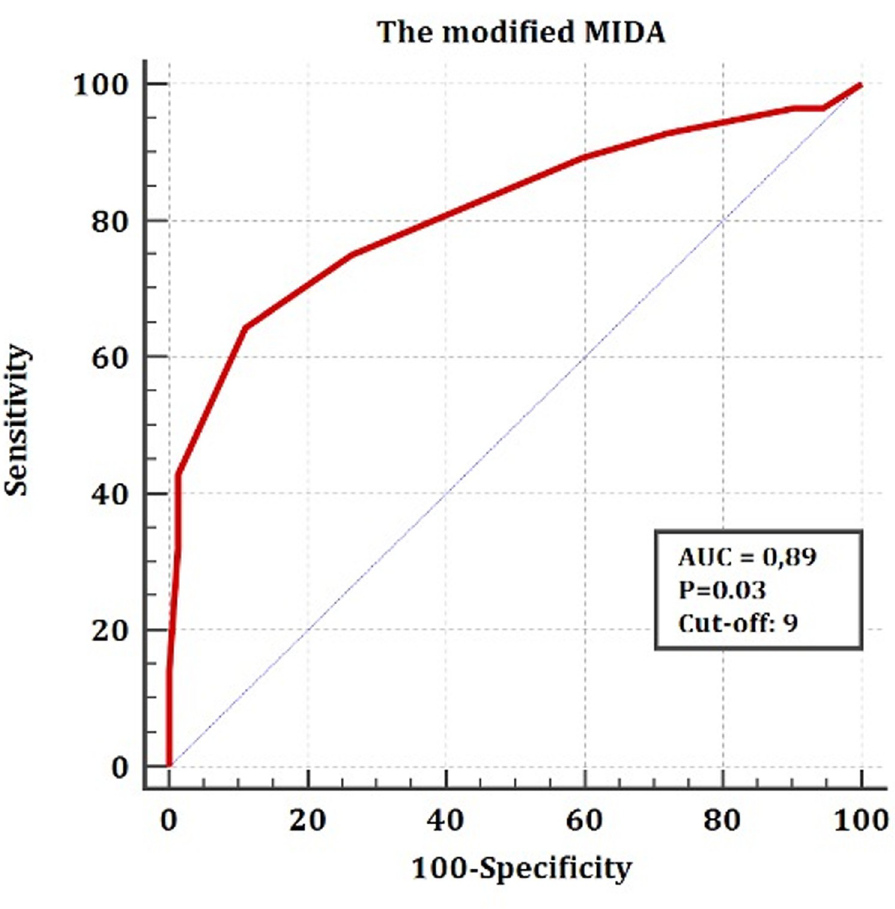
Fig 3. Prediction capability of the modified MIDA Score concerning the combined endpoint: The ROC analysis.